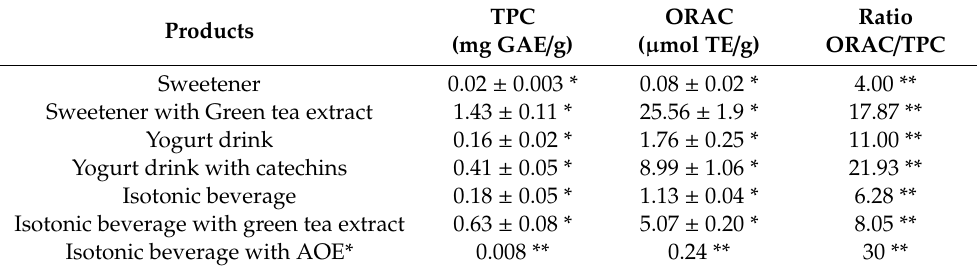
Table 5. Comparison of total phenols content (TPC) and oxygen radical absorbance capacity (ORAC) of some standard food and functional foods. GAE: gallic acid equivalents and TE: trolox equivalents.